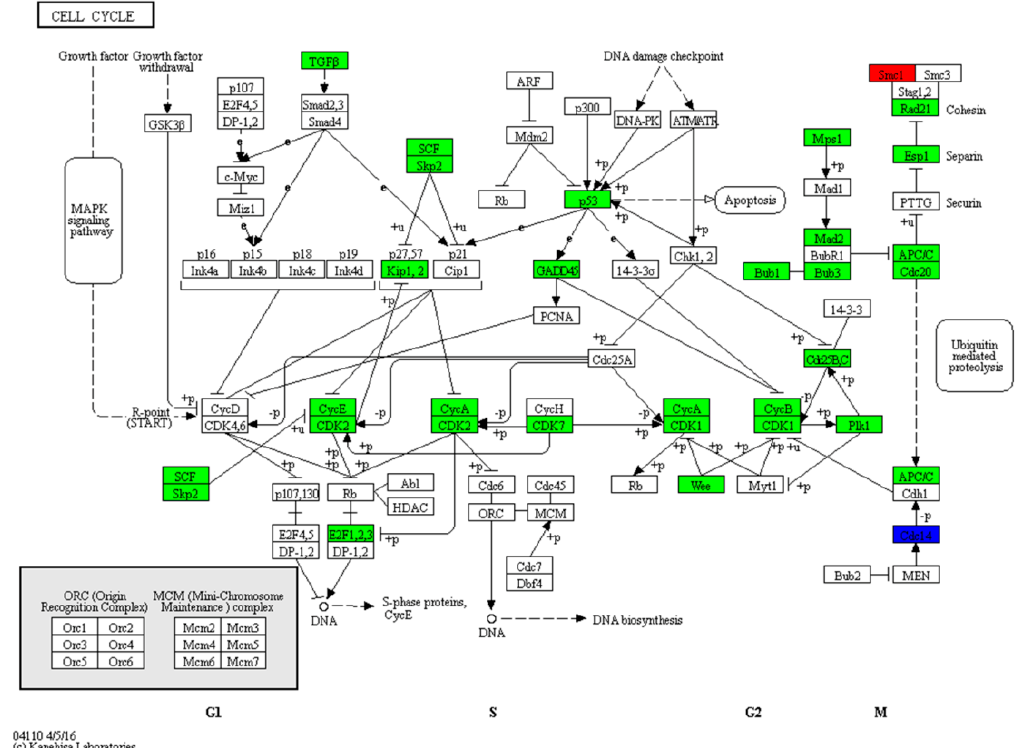
Figure 8. The differentially expressed genes associated with the cell cycle were annotated by KEGG. Red indicates up-regulated genes, green indicates down-regulated genes, and blue indicates genes that were both up- and down-regulated. The DEGs included rbx1 , skp2 , tgfb2 , cdkn1ca , ccna2 , ccnb3 , ccne2 , cdk2 , e2f2 , e2f3 , tp53 , gadd45ga , cdk7 , cdk1 , wee1 , ccnb1 , ccnb2 , ttk , mad2l1 , bub1 , bub3 , cdc25b , plk1 , smc1a , rad21a , espl1 , cdc20 , cdc23 , anapc10 , anapc13 , cdc14aa , cdc14b . “+p” indicates phosphorylation, “ − p” indicates dephosphorylation, “+u” indicates ubiquitination, and “T-bar” indicates inhibition.